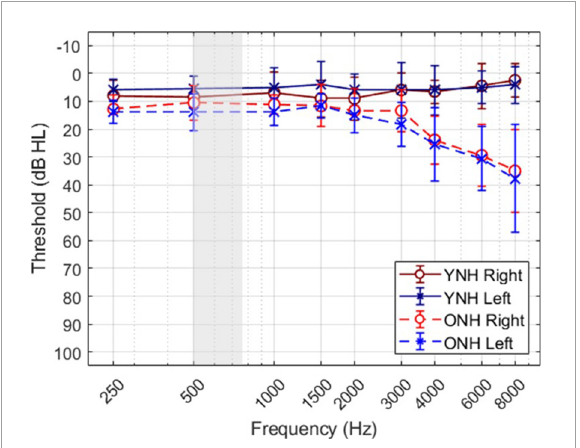
FIGURE1 Mean and standard deviation of audiometric thresholds for each ear of each group.